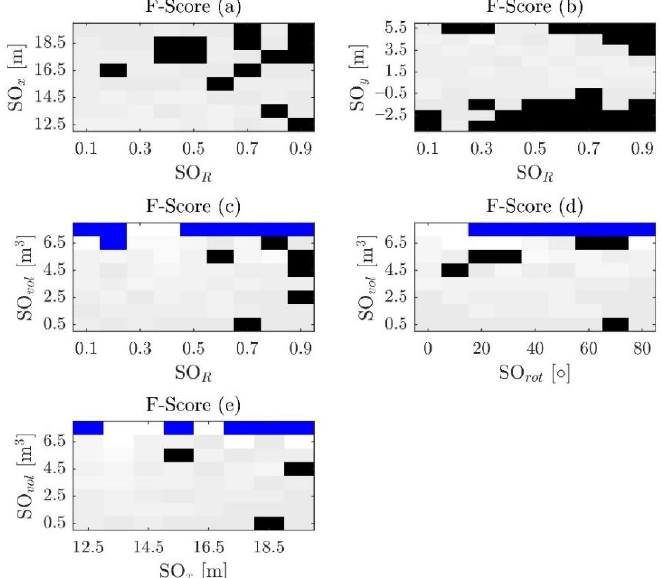
Figure A2. Continuation of Figure 9, including the dependencies for other parameters. In black regions with a F-Score lower than 92% are shown, and blue regions that are empty are shown (the combination of parameters currently does not contain any example). Besides the already explained parameters, SO R corresponds to the reflection of the synthetic object and SO rot to its rotation in degrees. In ( a – c ) high reflection values for the synthetic object seem to reduce the F-Score. A high reflection generates a high EPW value, high EPW values are more likely on the LV (Figure A4) making the classification harder. The rotation ( d ) and volume ( c – e ) do not seem to have a strong influence by